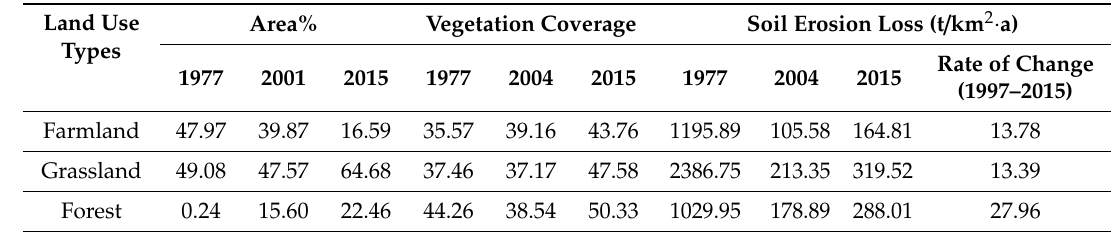
Table 5. Soil erosion and vegetation cover of di ff erent land uses in 1977, 2004 and 2015 in the study area. Land Use